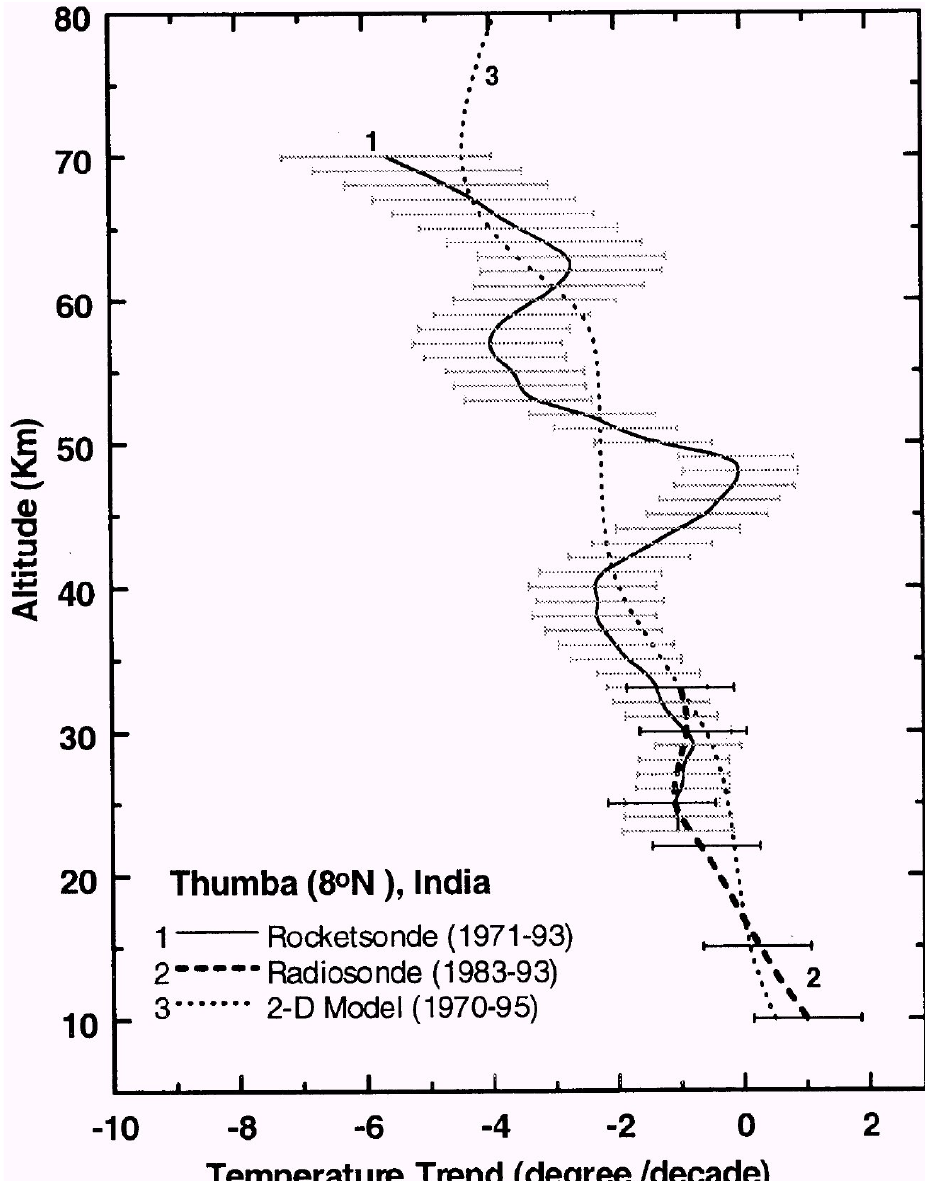
Fig. 14. Temperature trend for 8 ◦ N based on rocketsonde data obtained between 1971 and 1993 (after Beig and Fadnavis,